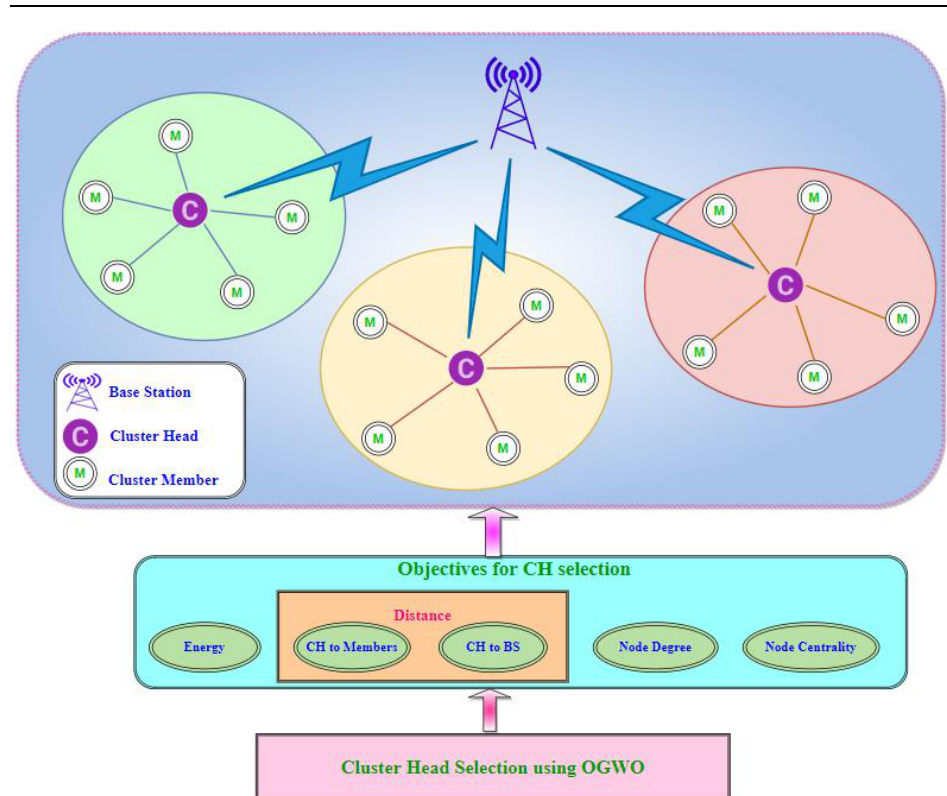
Figure 3. Cluster Head Selection Using OGWO.